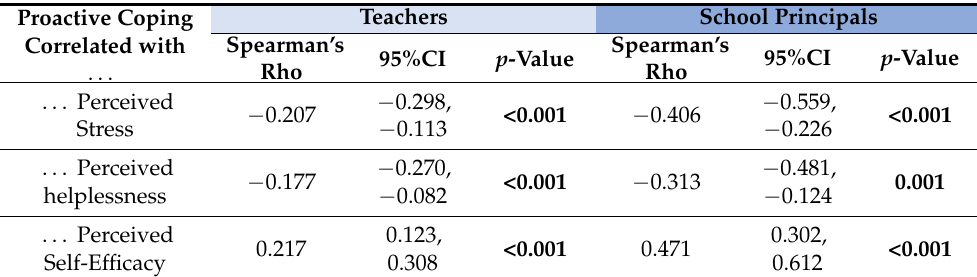
Table 5. Correlations between proactive coping (PCI) and perceived stress, perceived helplessness, and perceived self-efficacy (PSS-10).